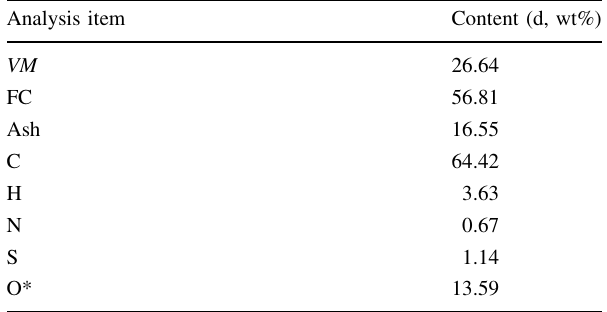
Table 1 Proximate and ultimate analyses of YCW Analysis item